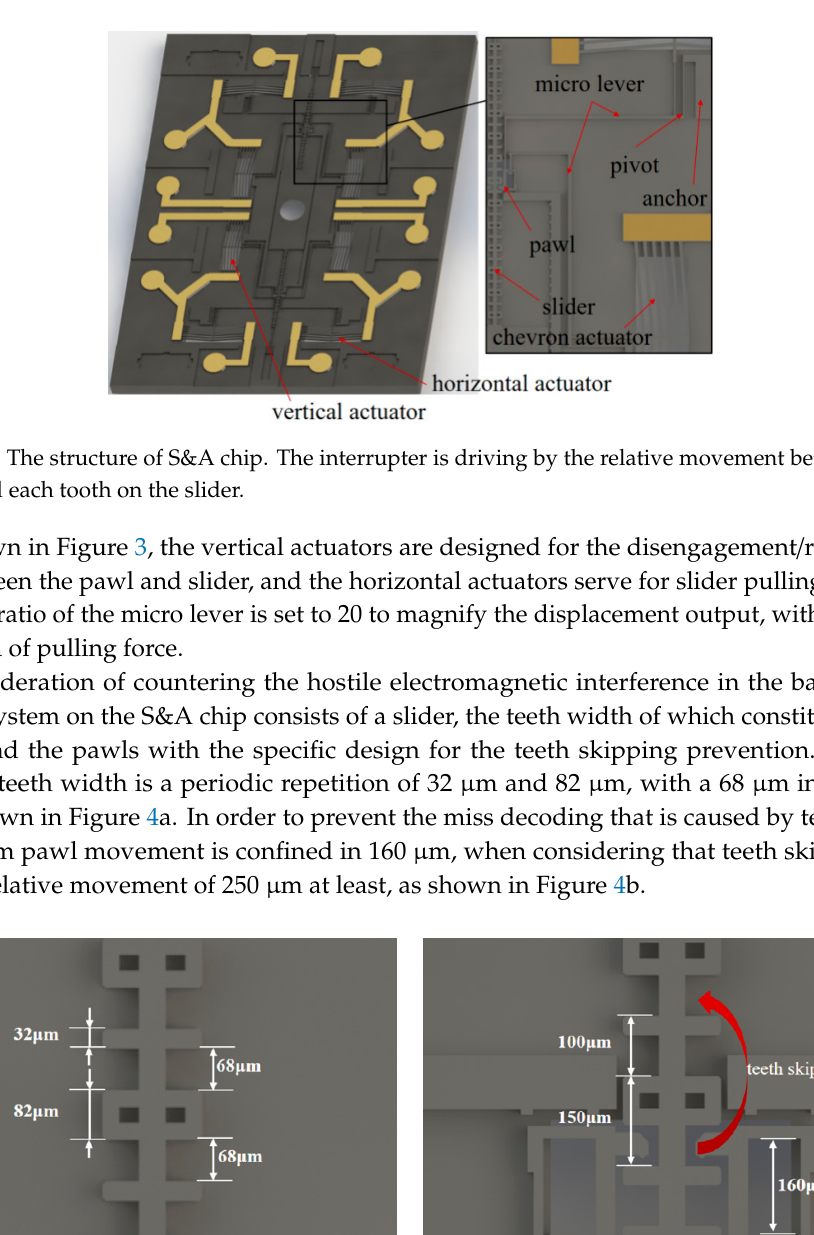
Figure 2. The conversion of the S&A (safety and arming) chip between safe status and arm status: ( a ) Safe status; and, ( b ) Arm status.